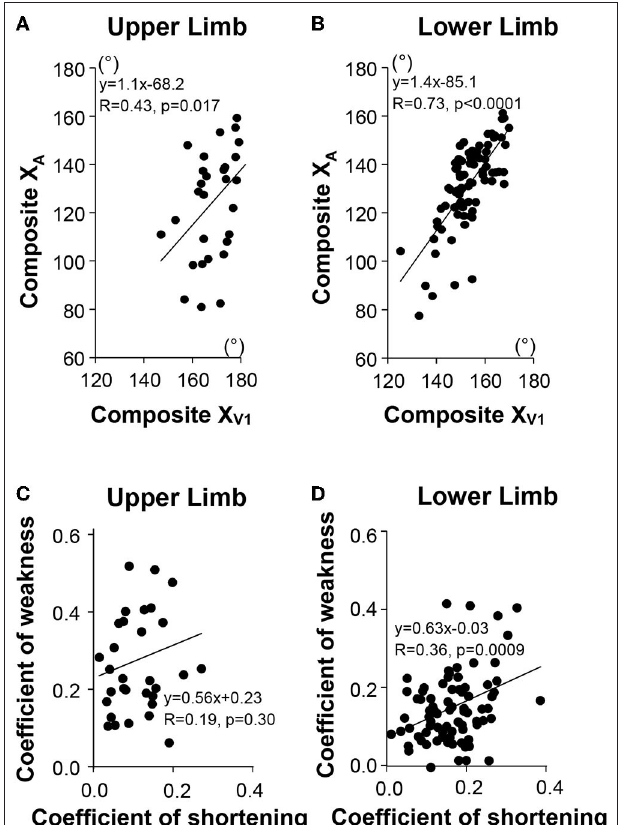
FIGURE 4 | Relationship between passive (X V1 ) and active movements (X A ) for the upper limb (A) , for the lower limb (B) . Composite X V1 , mean X V1 of the six investigated muscles; Composite X A , mean X A of the six investigated muscles. Relationship between the mean Coefficient of Shortening and the mean Coefficient of Weakness (Composite Scores) in the upper limb (C) , in the lower limb (D) , respectively.